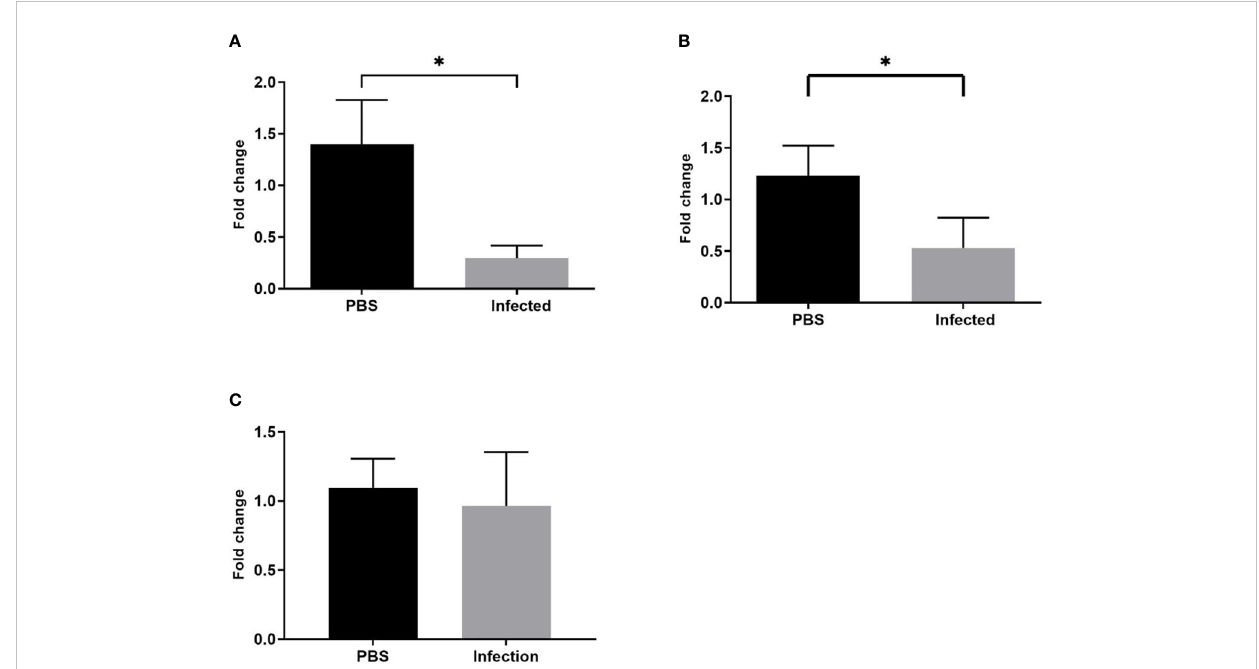
FIGURE 9 Pneumococcal infection leads to downregulation of Huwe1 and Itch expression in plaque macrophages. Gene expression (normalised to housekeeping gene 18s) of (A) Huwe1, (B) Itch and (C) Anapc1 in LCM derived plaque macrophages from infected mice compared with mock infected mice (*p<0.05,